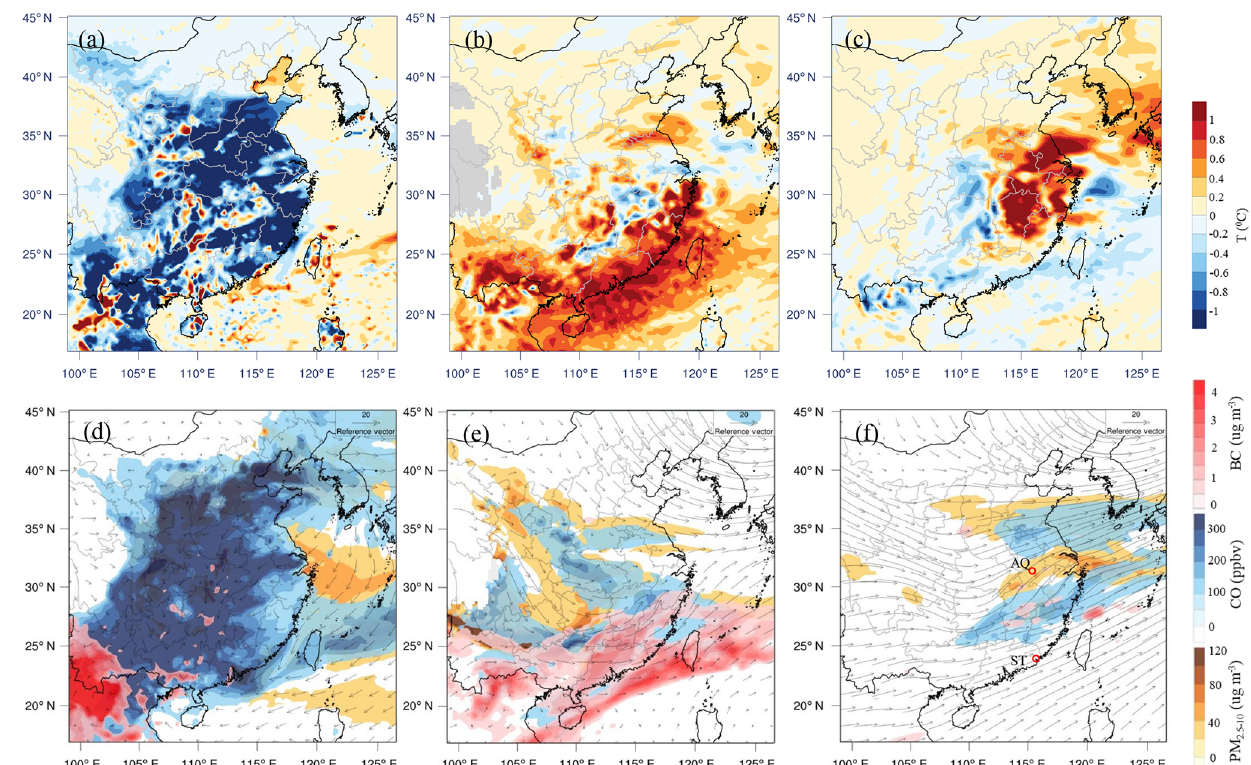
Figure 11. Spatial distributions of modeled air temperature change due to the meteorological feedback of mixed pollutants and pollutant distribution at (a, d) ground surface, (b, e) 4km in altitude and (c, f) 8km in altitude at 12:00LT on 23 March 2015.